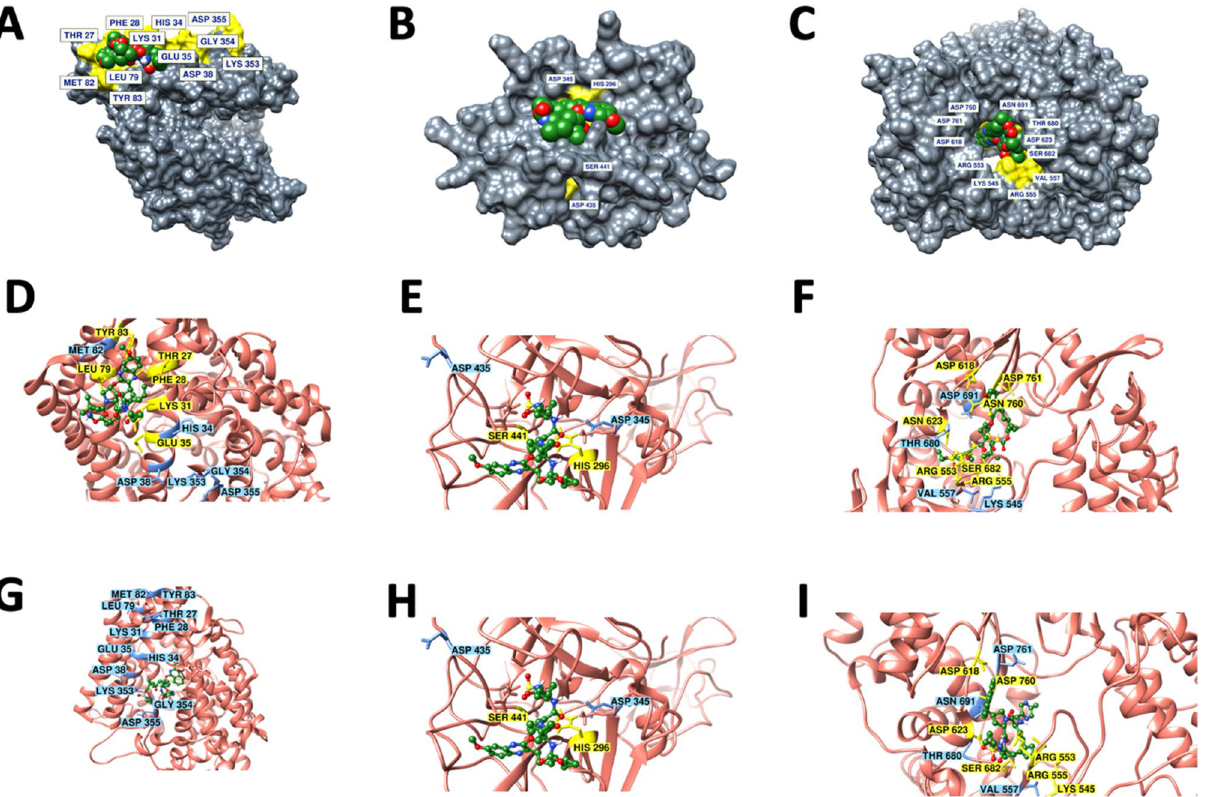
Figure 1. Surface plot and 2D interaction map of protein–ligand interactions of ( A , D ) ACE2-Grazoprevir ( B , E ) TMPRSS2-Grazoprevir and ( C , F ) RdRP-Grazoprevir complexes. ( G ) ACE2-Paritaprevir ( H ) TMPRSS2- Paritaprevir ( I ) RdRP-Paritaprevir complexes showing best fit conformation having the highest binding energy selected for each protein, for our further studies, out of all the conformations generated. Grazoprevir is shown in space filled representation in the the top pannel. Key residues that are reported to be critical either for SARS- CoV-2-host interactions and/or the catalytic activity of these proteins are displayed in yellow and the ones not interacting yet important are displayed in blue. Proteins and ligands are shown in cartoon and ball & stick representations respectively in middle and lower All the docked conformation of each ligand was ranked according to its binding energy from highest to lowest (see, supplementary Table 1). All the conformations were visualized and analyzed. Among 45 ligands, the top ten ligands were selected for further analysis (Table 1). Paritaprevir and Grazoprevir were among the top ten ligands which reflected an optimal binding affinity with all the three target proteins. This is worth mentioning, that despite better binding affinity of Paritaprevir, Grazoprevir was selected for further analysis as it interacts with the key residues of the target protein, particu- larly ACE-2 and RdRP (Fig. 1 and Figure S2) as discussed below. In case of ACE2, Grazoprevir interacts with the residue Gln76, forming a H-bond while residues Thr27, Phe28, Lys31, Glu35, Leu39, Phe72, Glu75, Leu79 and Tyr83 are involved in hydrophobic/polar interactions as displayed in Fig. 1D and Figure S2A. On the other hand, out of all the conformations generated for Paritaprevir, none was shown to bind with the critical resi- dues of ACE-2 (Fig. 1G and Figure S2D). In the case of RdRP, both Grazoprevir and paritaprevir interact with similar numbers of key residues (Fig. 1 and Figure S2). However, a thorough analysis showed that Grazoprevir is able to interact with key residues Arg553, Arg555, and Asp623 through five H-bonds and exhibits strong H-bond network with residues Arg555 and Arg553 of nucleoside triphosphate (NTP) entry channel in motif F of RdRP 20 (Figure S2C), whereas paritaprevir could not able to interact with any key residues through H-bonds (Fig. 1I and S2F). It is important to mention that H-bond is one of the important non-covalent interactions responsible for the specific to the ligand–protein complexation and thereof drug action. Therefore, in spite of better binding affinity, paritaprevir may be less potent in inhibiting the NTP entry channel compared to the Grazoprevir; hence was not considered for further evaluation. Further, we would like to mention that in the case of TMPRSS2, both Grazoprevir and paritaprevir interact with identical key residues (Fig. 1E, 1H, and Figure S2), therefore if aim is to only target the TMPRSS2, then paritaprevir could be the alternative choice. Considering these above facts intact, the Grazoprevir was selected over paritaprevir as it has optimal interactions with the key residues in case of all the three targets (ACE2, TMPRSS2 and RdRP) protein that takes part in human and virus interaction 20–22 , thus making an integral component for the proposed anti-COVID activity.